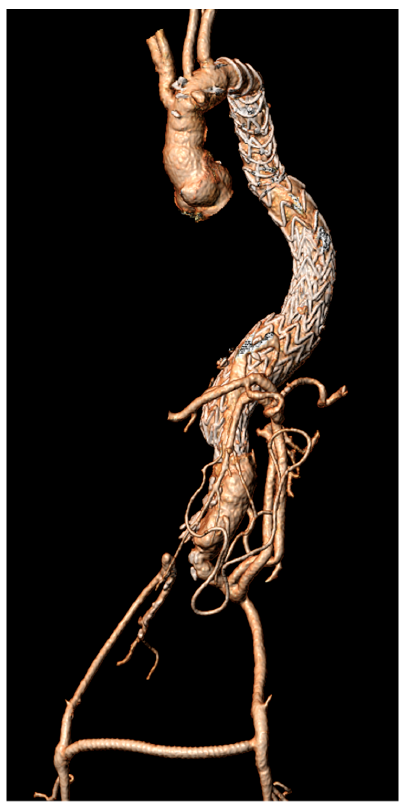
Figure 4. Illustrations depicting the endovascular intervention. The first stent graft (green) was guided into position along the route indicated by the green line (left femoral artery–aortic FL–dSINE–aortic TL). A second stent graft (purple) was placed in continuation of the first to restore the luminal conformation of the aorta. A visceral debranching graft was implanted beforehand to ensure proper blood supply to the left renal artery, superior mesenteric artery, and the celiac trunk. dSINE—distal stent graft-induced new entry; F-F—femoro–femoral; FL—false lumen; TL—true lumen.